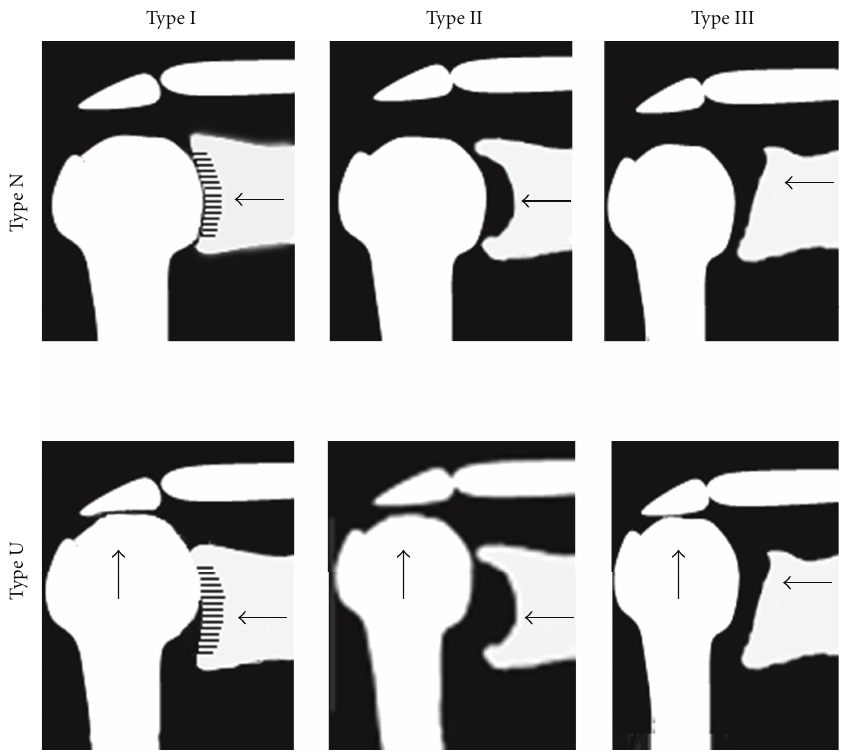
Figure 4: A classification system based on the changes in shape of the glenoid fossa and on an evaluation of the upward migration of the humeral head.